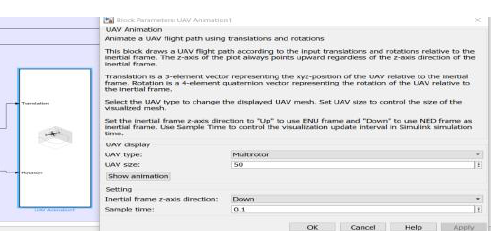
Figure 14. The parameter of UAV animation block